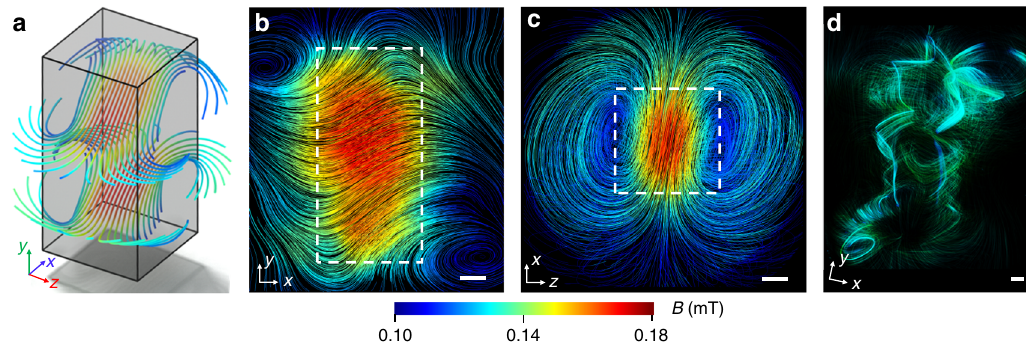
Fig. 3 Magnetic vector fi eld inside a superconducting lead sample measured at T = 4.3 K. a Some selected magnetic fi eld lines show the location of the magnetic fi eld inside the sample indicated by the cuboid. b Magnetic fi eld lines in a selected xy plane (silhouette of the lead sample marked by dotted lines). Scale bar, 5 mm. c Magnetic fi eld lines in a selected xz plane. Scale bar, 5 mm. d Selected swirling magnetic fi eld lines as also seen in